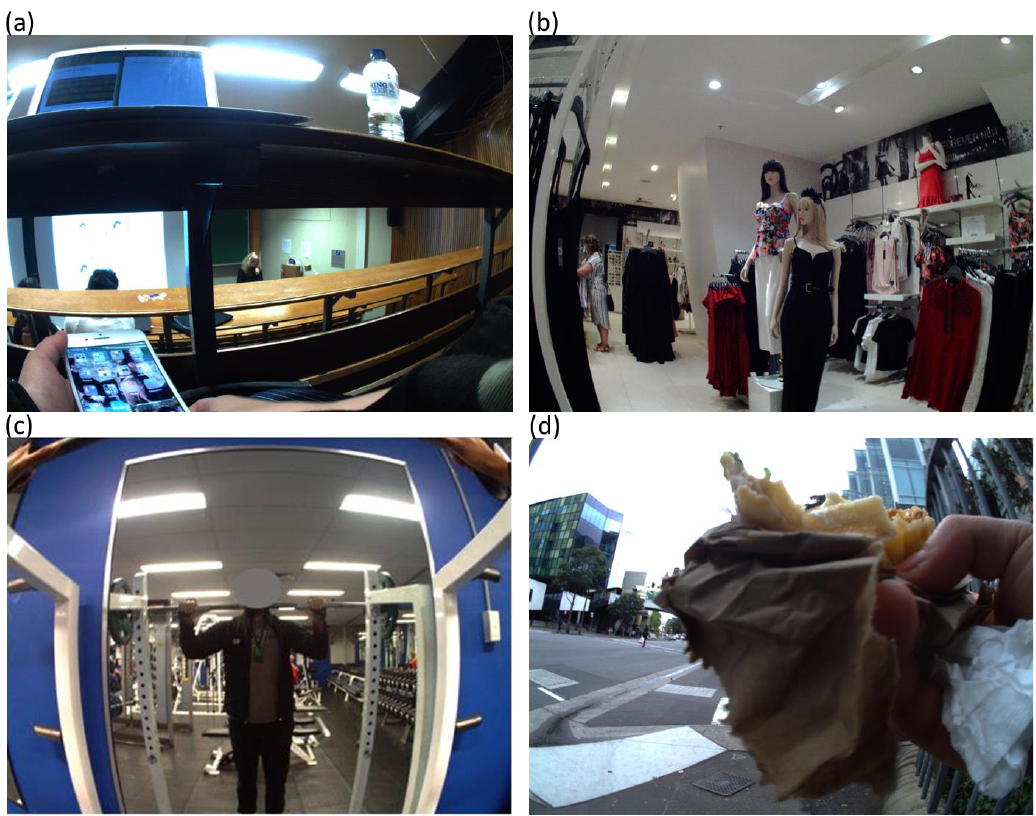
Figure 1. Sample coding using wearable camera images of sedentary, light and